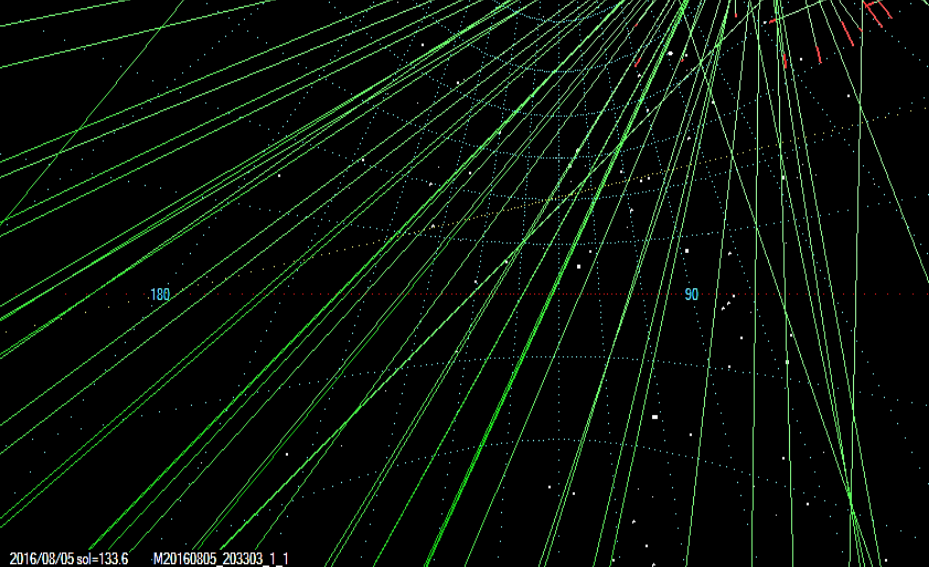
Fig. 4 Trail map for meteors observation during 5-13 August